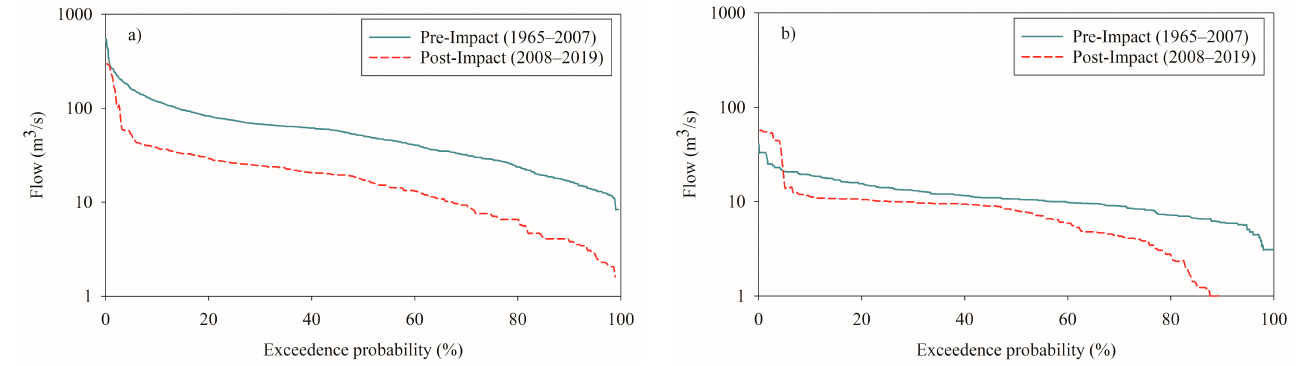
Figure 7. Variations of the exceedance probability against flow rate for ( a ) March and ( b ) July. Table 12. Comparison of different methods of determination of the EWR for the Kor River.